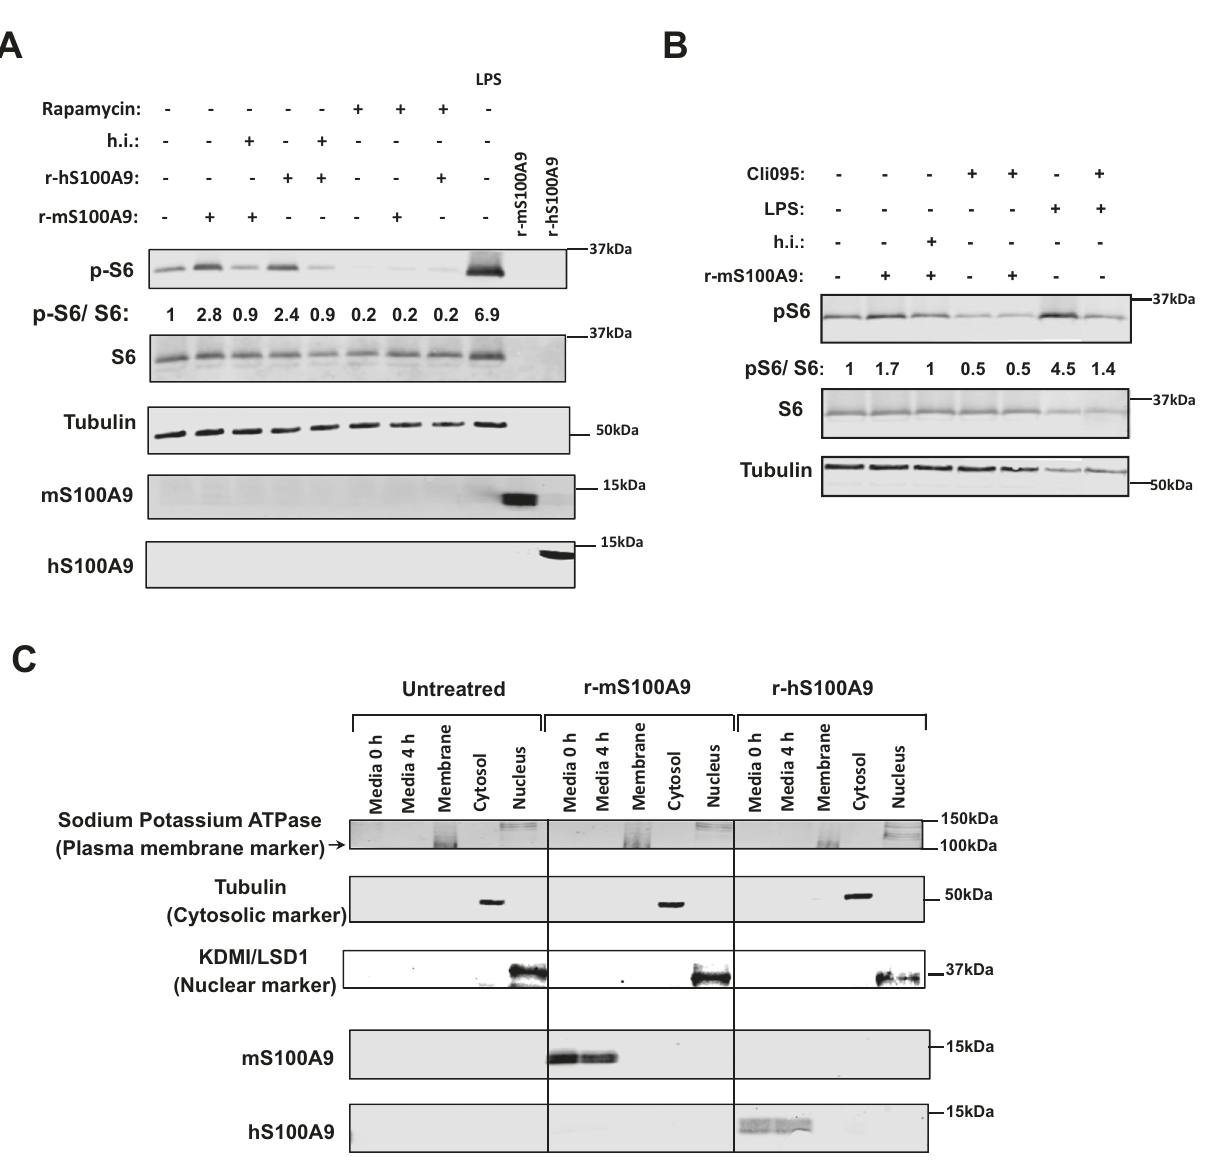
Fig. 5 Extracellular S100A9 activates mTORC1 signaling in a cell-autonomous fashion. A RAW264.7 cells were incubated with 2 μ g/mL of r-mS100A9 or r-hS100A9 (or their heat inactivated (h.i) forms) or 1 μ g/mL of lipopolysaccharides (LPS, from E.coli O111:B4, Sigma) for 4 h, with or without 20 uM Rapamycin and cell lysates were analyzed by western blot. B RAW264.7 cells were incubated wit 2 μ g/mL of r-mS100A9 or (or its heat inactivated form) in the presence or absence of 1 μ g/mL of Cli095 (Invivogen) and cell lysates were analyzed by western blot. C RAW264.7 cells were incubated with 2 μ g/ mL of r-mS100A9 or r-hS100A9. Cells were fractionated and membrane, cytosolic and nuclear fractions were subjected to western blot alongside culture media. ( n = 1 × 10^6 cells examined). Western blot images shown in B are cropped images. Source data are provided as a source data fi le. NATURE COMMUNICATIONS| (2022) 13:4107